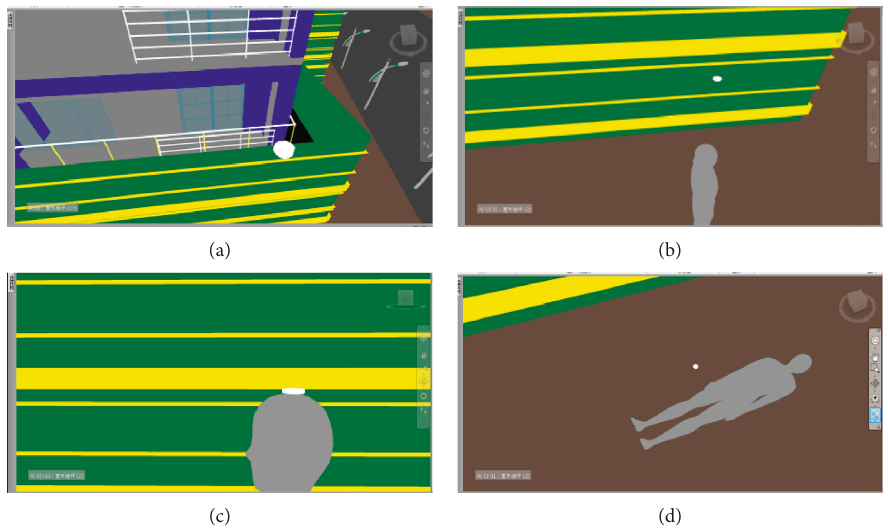
Figure 8: Schematic diagram of the animation of the accident.